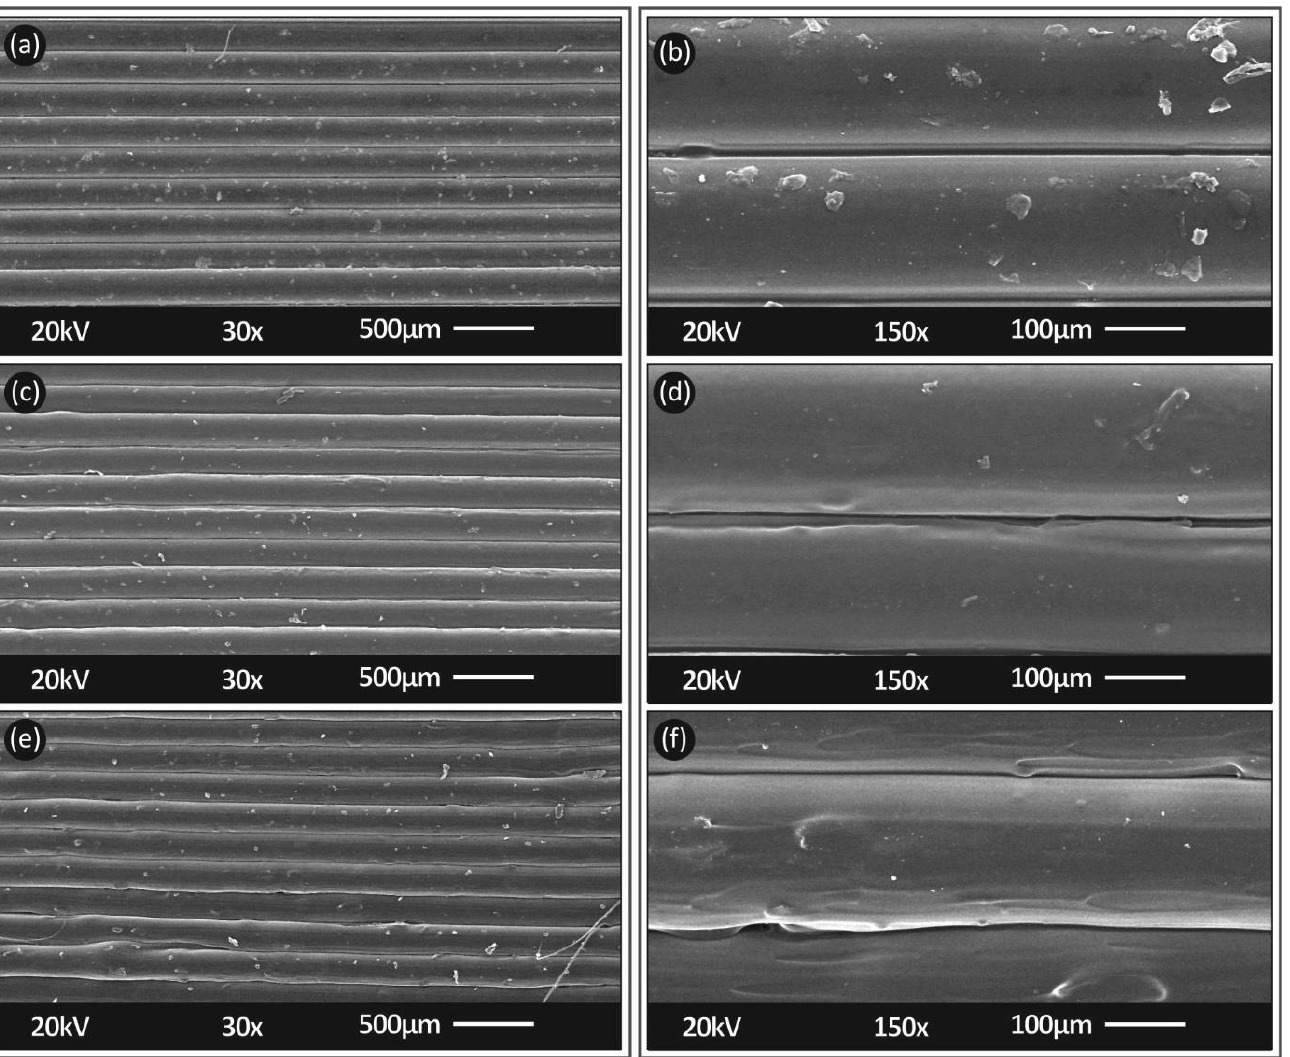
Figure 7. Side tensile specimens’ surface in two different magnifications for all tested materials, ( a , b ) pure PC, ( c , d ) PC CNF 0.5 wt.%, ( e , f ) PC CNF 1.0 wt.%.